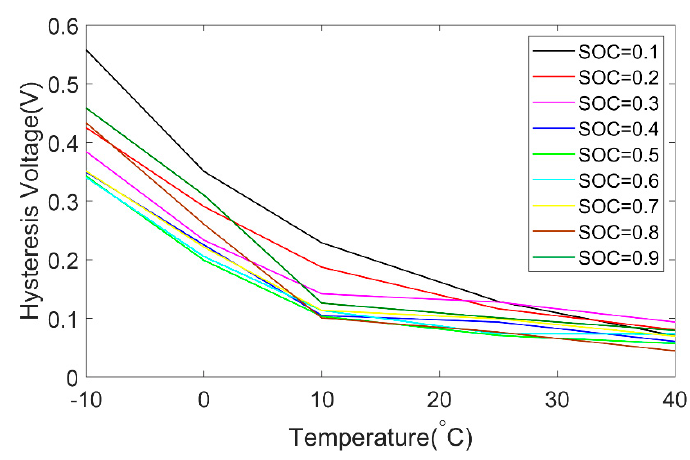
Figure 4. Maximum hysteresis voltage curve at different temperatures.